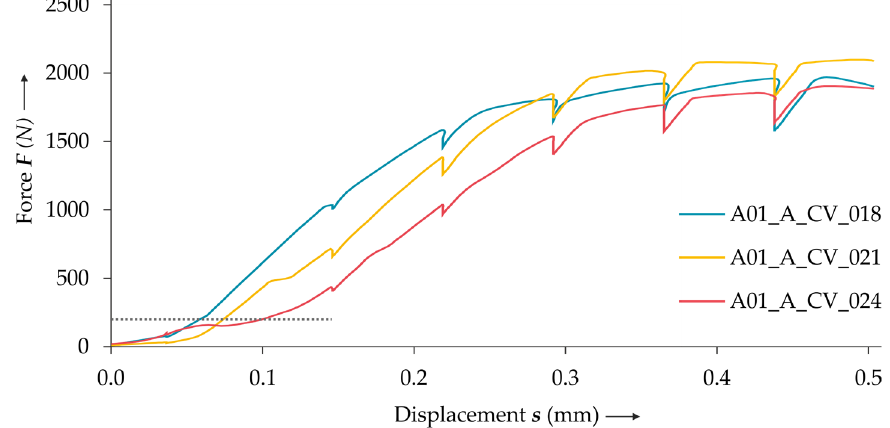
Figure 6. The results of the lap shear tests. The baseline value 200 N is marked with a dotted line.